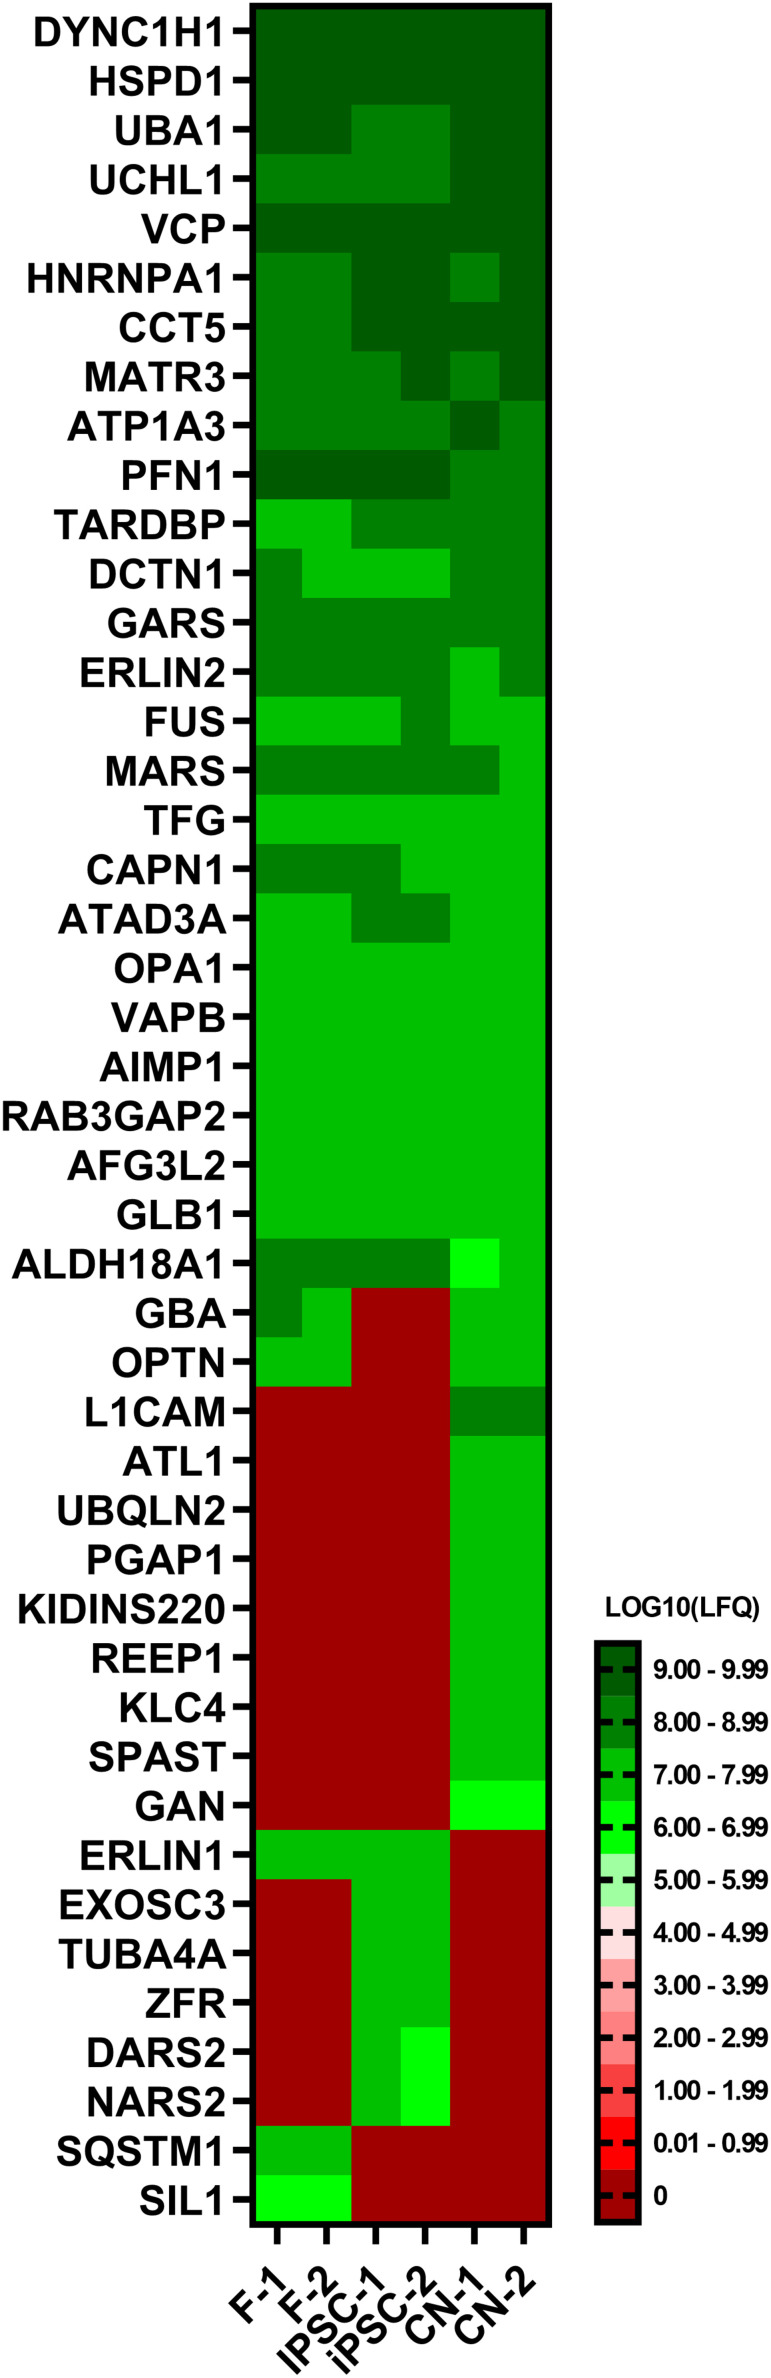
Proteome analysis of fibroblasts, iPSCs and cortical neurons. Heatmap of untargeted proteome analysis in fibroblasts, iPSCs and cortical neurons displaying consistently identified MND-proteins. Mean values of technical triplicates are given as LOG10 label-free quantification (LFQ) intensity.